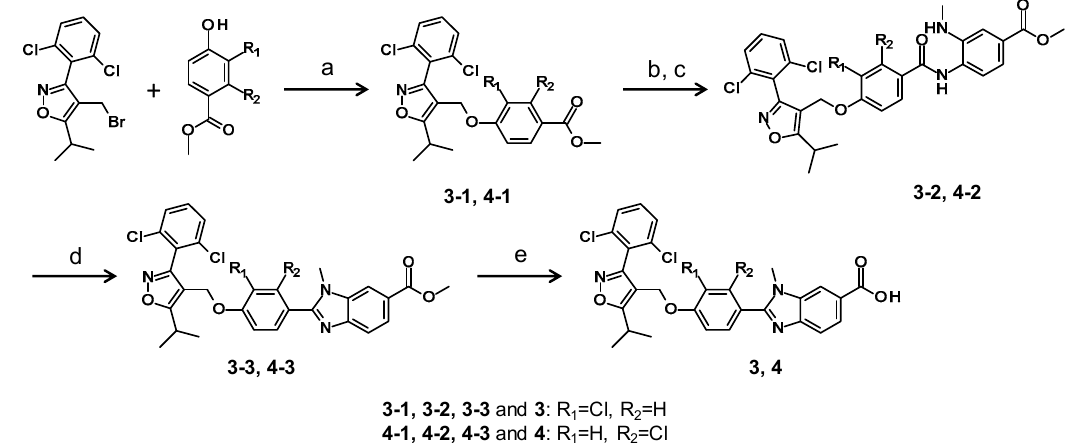
Table 1. Binding ability of FXR agonists by TR-FRET binding